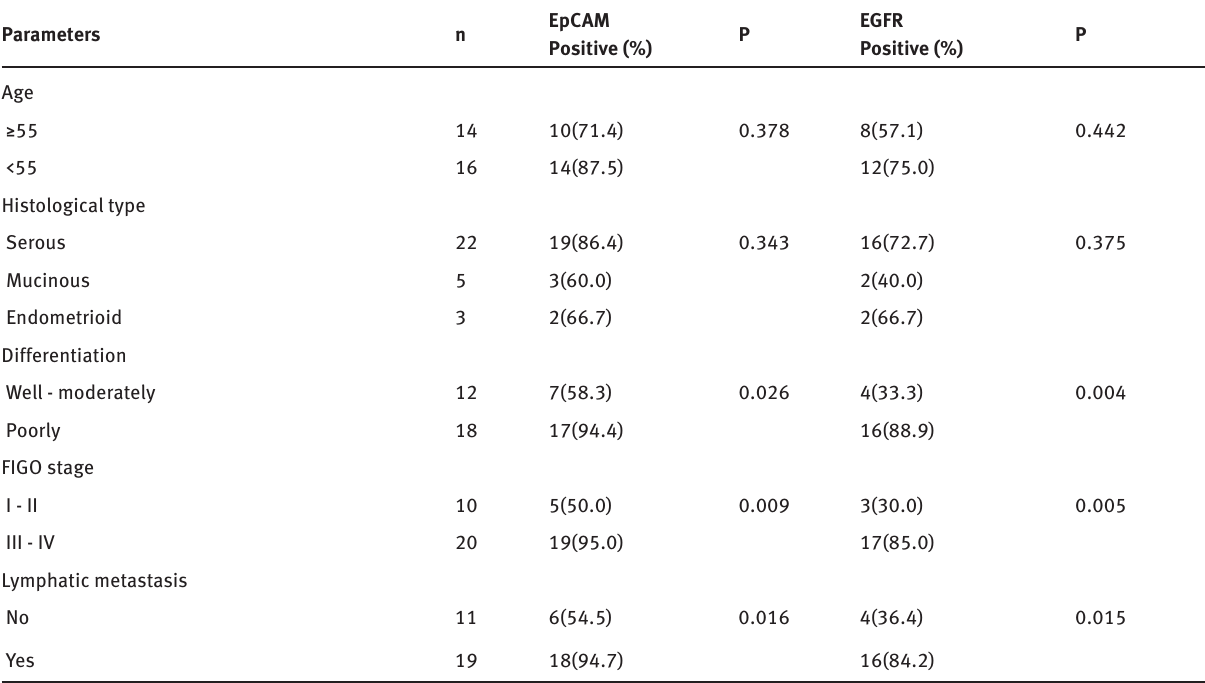
Table 1: Correlation of EpCAM and EGFR expression with clinical pathological parameters in epithelial ovarian carcinoma